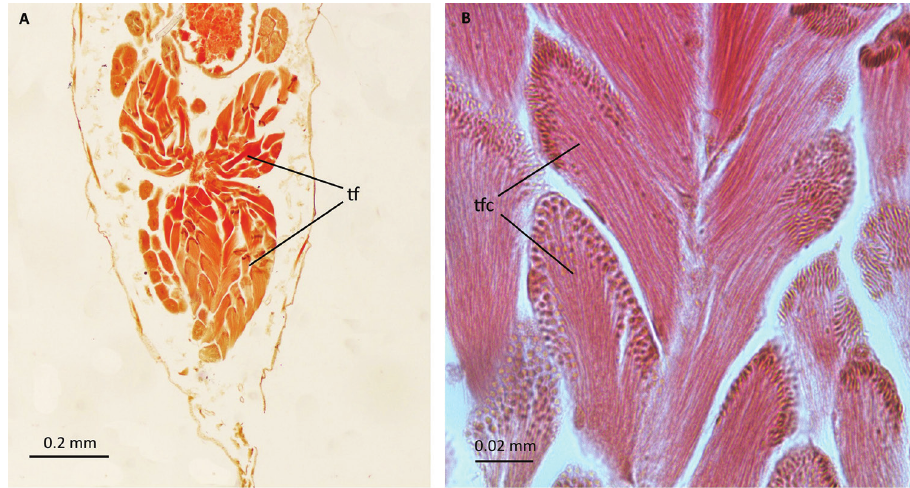
Figure 6. Male reproductive system of P. tremulae : A, B cross sections through testes; tf – testicular fol- licles, tfc – testicular follicle